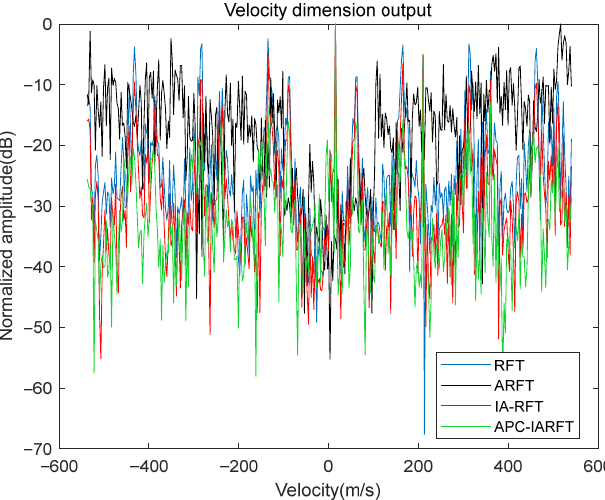
Figure 16. Velocity-dimension output of four methods in Scenario 4.